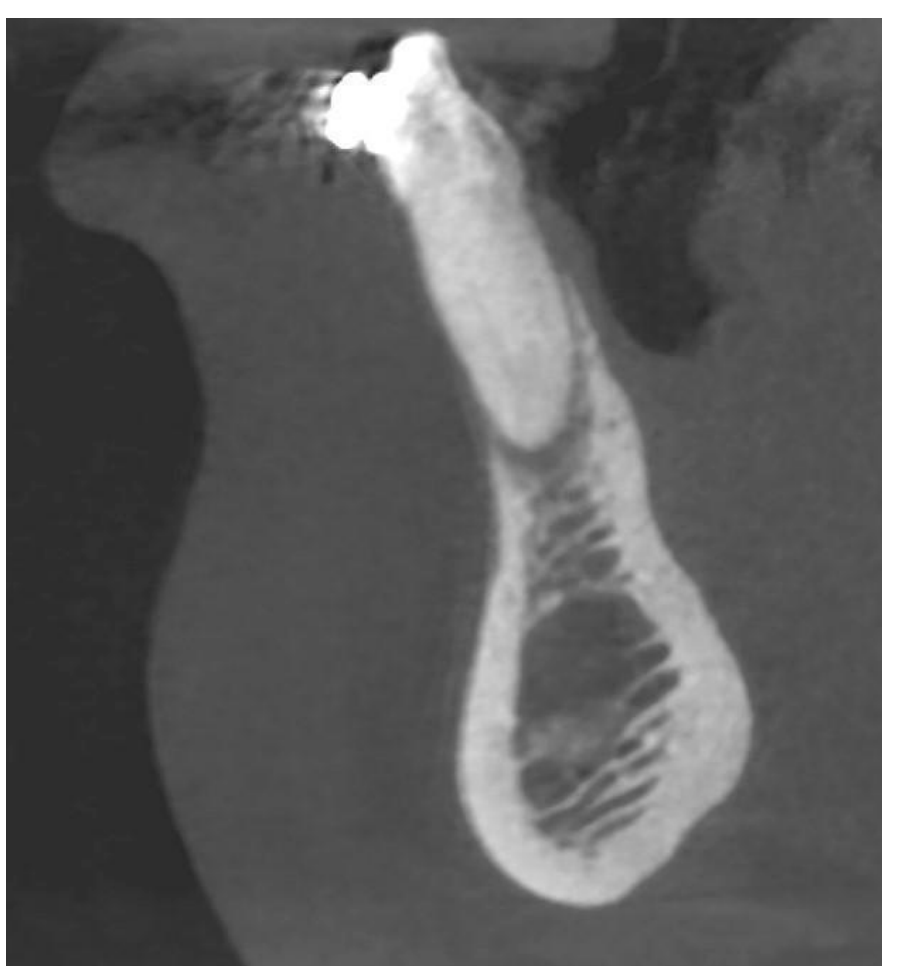
Figure 3. CBCT image before the treatment showing an almost complete loss of the buccal bone— sagittal section.